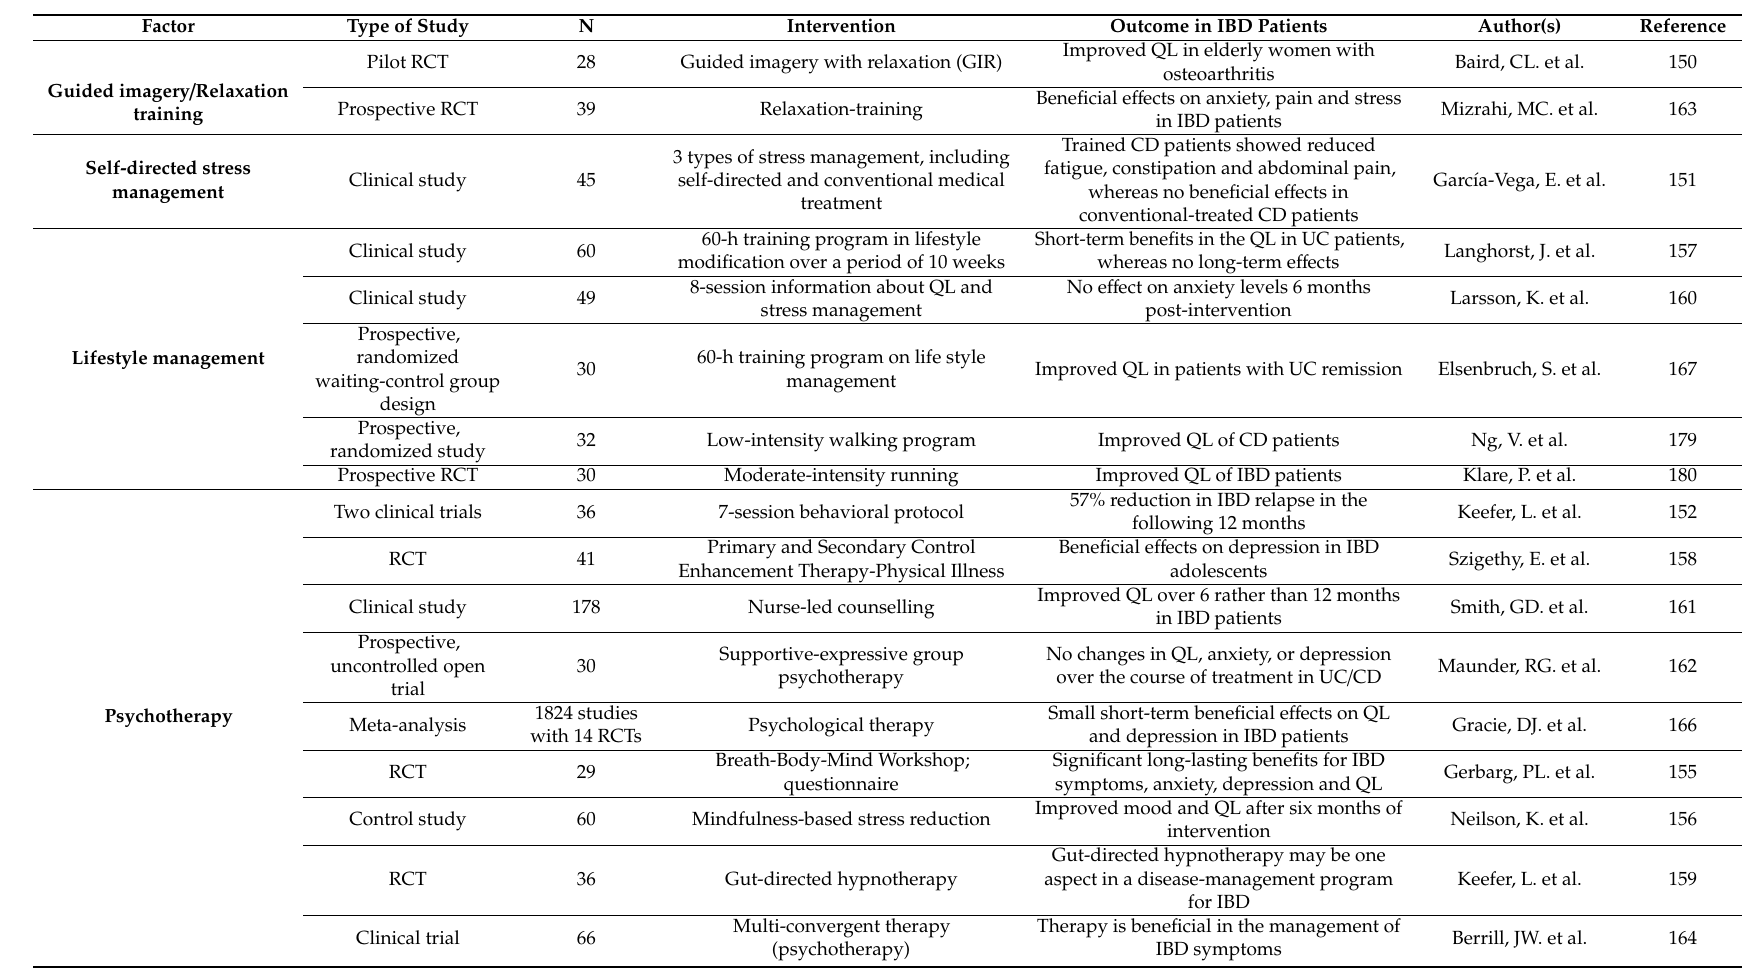
Table 3. Clinical studies investigating stress management in